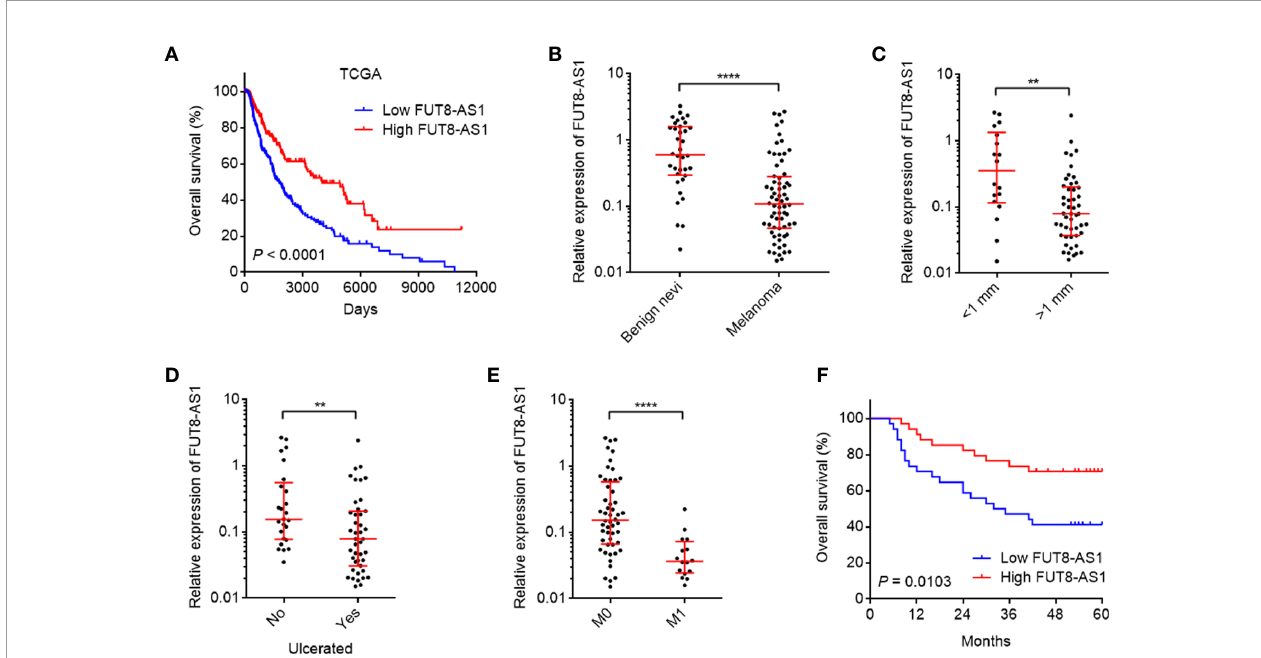
FIGURE 1 | The expression and clinical relevance of FUT8-AS1 in melanoma. (A) Kaplan-Meier survival curves of skin cutaneous melanoma (SKCM) from TCGA dataset strati fi ed by FUT8-AS1 expression (low 50% [n = 229] versus high 50% [n = 229]). P < 0.0001 by log-rank test. (B) FUT8-AS1 expression in 36 benign nevi and 68 melanoma tissues was measured by real-time PCR. (C) FUT8-AS1 expression in 18 melanoma tissues with thickness <1 mm and 50 melanoma tissues with thickness >1 mm. (D) FUT8-AS1 expression in 25 melanoma tissues without ulceration and 43 melanoma tissues with ulceration. (E) FUT8-AS1 expression in 52 melanoma tissues without distant metastasis and 16 melanoma tissues with distant metastasis. For (B – E) , data are presented as median with interquartile range. ** P < 0.01, **** P < 0.0001 by Mann-Whitney test. (F) Kaplan-Meier survival curves of 68 melanomas strati fi ed by FUT8-AS1 expression (low 50% [n = 34] versus high 50% [n = 34]). P = 0.0103 by log-rank